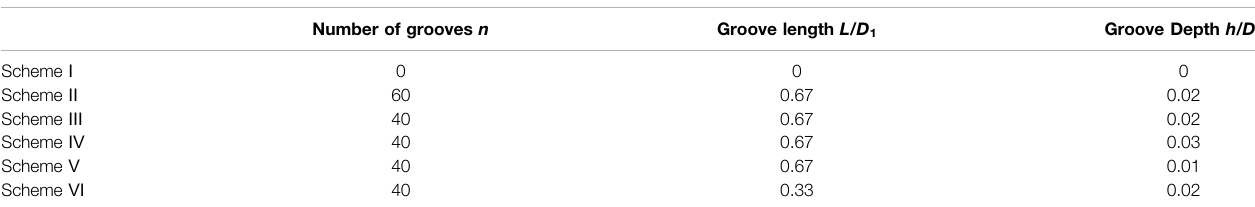
TABLE 1 | Schemes of inlet grooves of different full-tubular pumps.